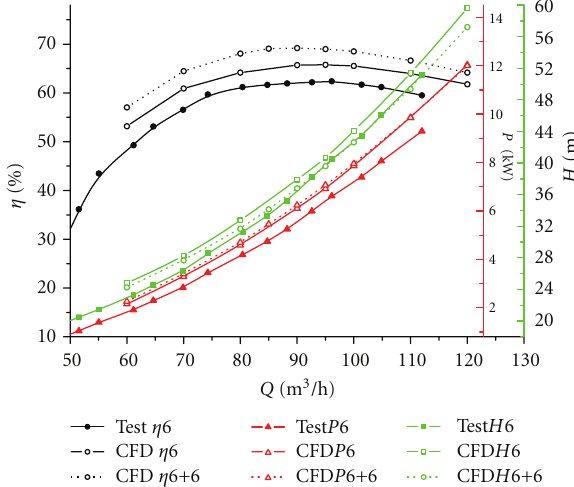
Figure 5: Comparison between experimental and numerical results.